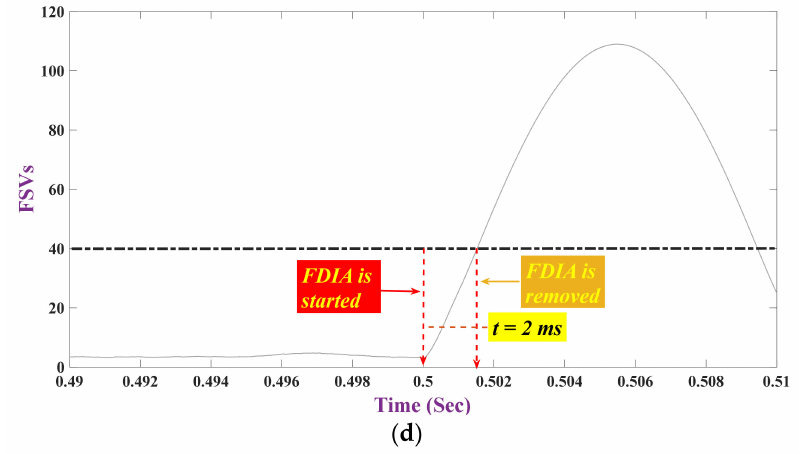
Figure 7. Instability stems from manipulating the voltage reference signal according to shift the signal: ( a ) ISMG’s voltage; ( b ) Loads current; ( c ) FSVs of signals; ( d ) Time response of FSV’s scheme (FDIA is initiated at t = 0.5 s and is omitted at t = 1 s).